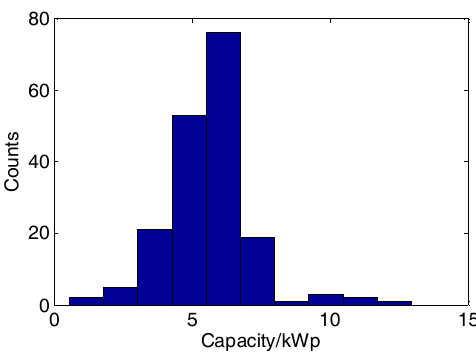
Figure 8. The distribution of DPVS capacities for the 183 customers.